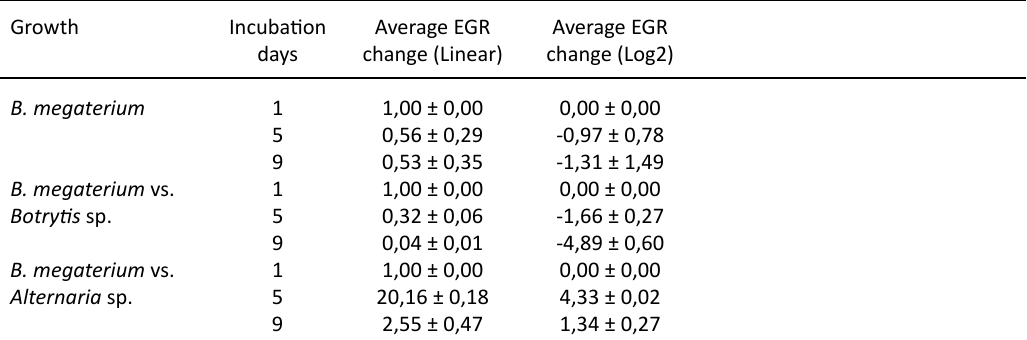
Table 2. Change in relative gene expression (RGE) of the FEND gene in Bacillus megaterium alone and against pathogens Growth